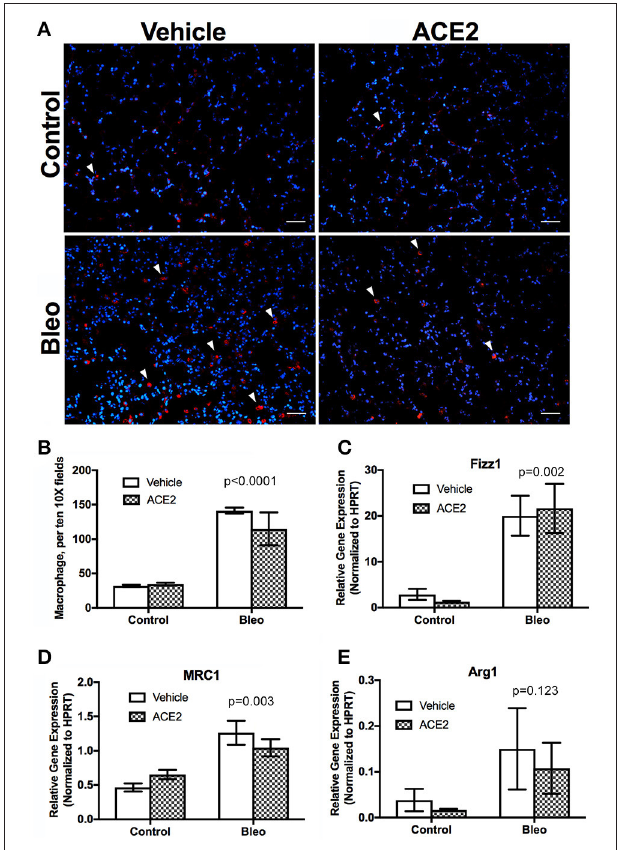
FIGURE 3 | Pulmonary macrophage dynamics in group 3 PH animals. Lung sections were stained for CD68 and random fields photographed at 10X and CD68 + cells counted (A,B , n = 4). RNA was isolated from frozen lungs and RT-PCR used to assess the expression of markers of macrophage polarization. (C) Retnla (Fizz1), (D) MRC1, (E) Arg1. Data presented in (C–E) are mean ± SEM, n = 4, 5, 6, and 6 for the control, ACE2, Bleo and Bleo + ACE2 groups respectively. Bleomycin-treated groups significantly differed from control groups by two-way ANOVA followed by Holm-Sidak’s post-test, p < 0.0001 in (B–E) . Scale bars shown are 50